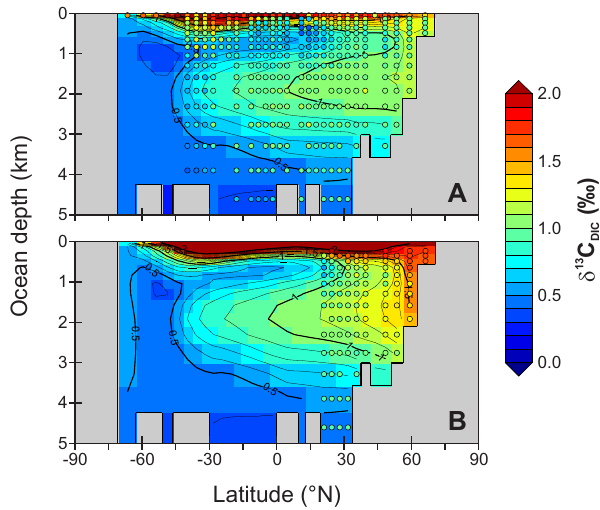
Fig. 11. Ensemble-averaged δ 13 C DIC transects through the Atlantic (25 ◦ W) at the end of the 1858 to 2008AD transient simulations (upper panel) and from the pre-industrial spun-up states (lower panel). The 2008 simulations are compared with GLODAP bottled measurements (1990s, Key at al., 2004), averaged over the appro- priate GENIE grid cell. The pre-industrial simulations are compared with the reconstruction of Olsen and Ninnemann